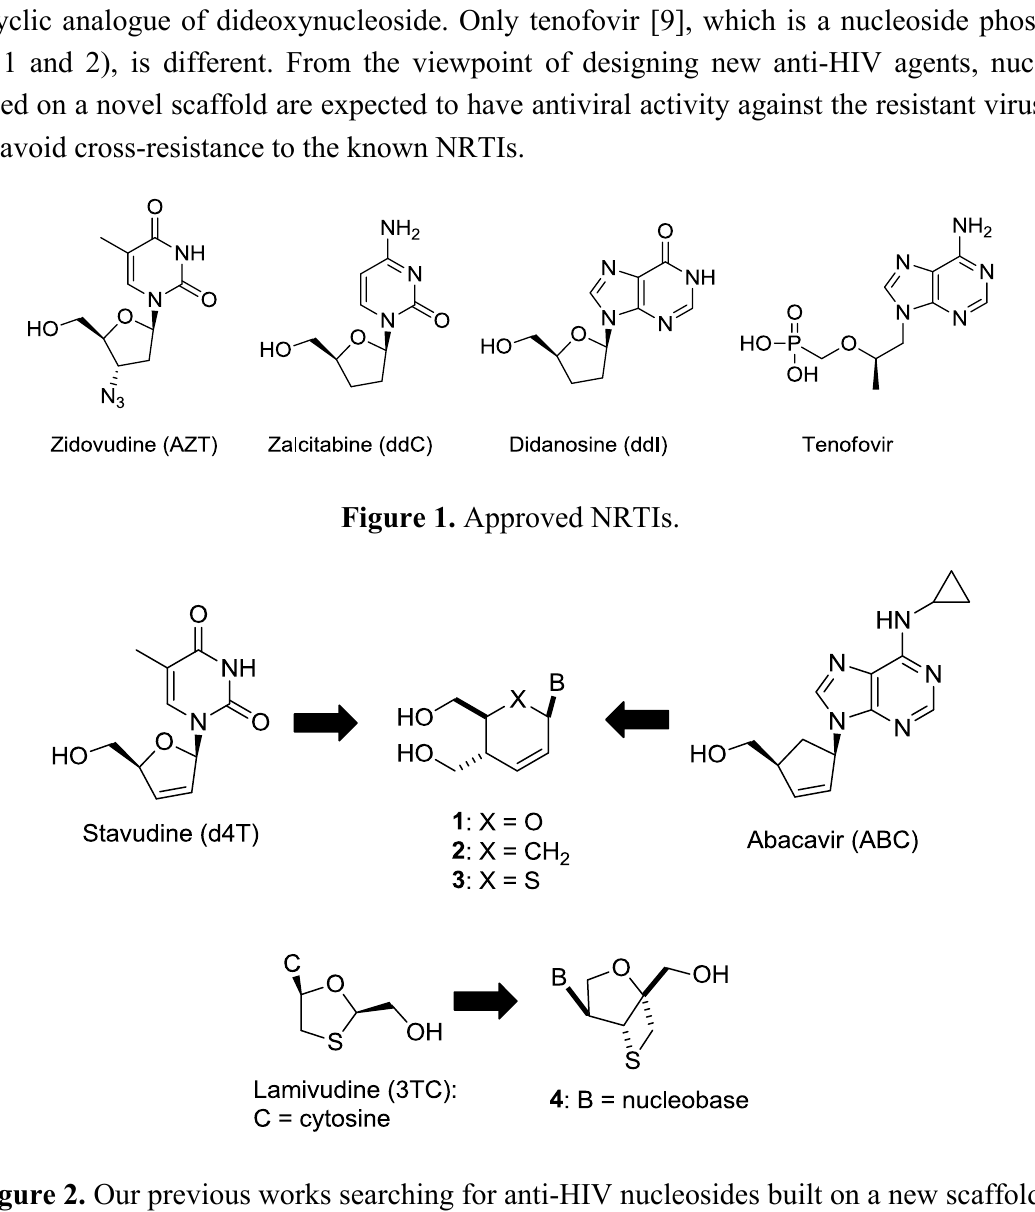
Figure 2. Our previous works searching for anti-HIV nucleosides built on a new